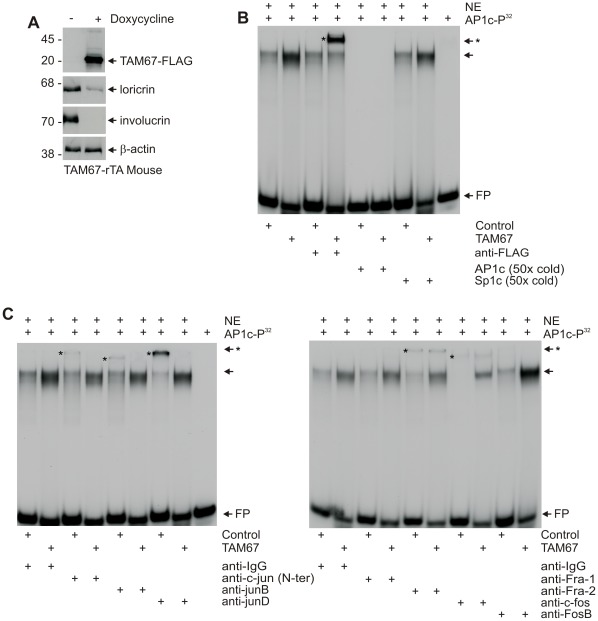
Impact of TAM67 on AP1 factors in vivo.TAM67-rTA mice were treated with (+) or without (−) 2 mg/ml doxycycline in drinking water for 3 days. A Murine epidermis was collected free of the dermis by high temperature separation as previously described [35]. Total extract was prepared for immunoblot to detect the indicated proteins. TAM67-FLAG was detected with anti-FLAG. B Interaction of TAM67 with AP1 site consensus element. Nuclear extracts were prepared from epidermis and incubated with AP1c-P32 and other probes as indicated. FP indicates free probe, NE indicates nuclear extract. Similar results were observed in each of three experiments. C Impact of TAM67 on interaction of endogenous AP1 factors with AP1 site element. Nuclear extracts were prepared from TAM67-negative and TAM67-expressing epidermis and incubated with the AP1c-P32 and antibodies as indicated. The complexes were then separated on a non-denaturing 6% polyacrylamide gel. FP indicates free probe and NE is nuclear extract. Note the reduction in jun factor binding in the presence of TAM67-FLAG (left panel). We did not observe a significant reduction in fos factor interaction in the presence of TAM67 (right panel).